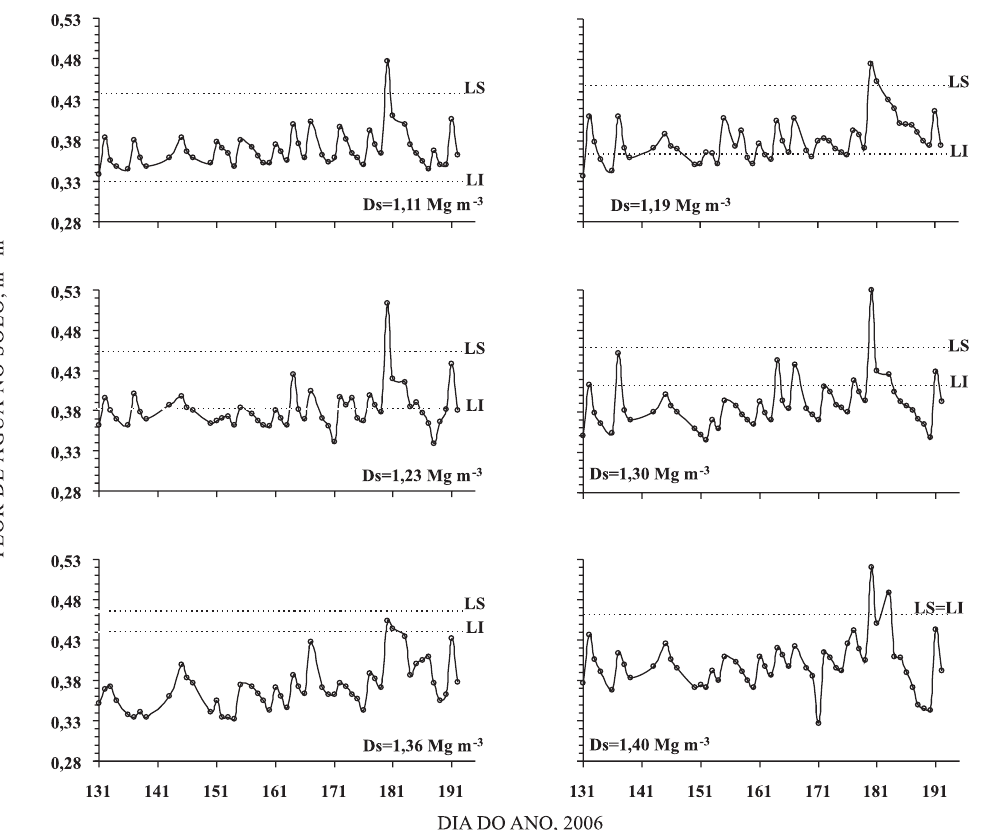
Figura 2. Variação temporal do teor de água no solo em relação aos limites críticos do Intervalo Hídrico Ótimo, Ls – limite superior, e Li – limite inferior do IHO para o período de